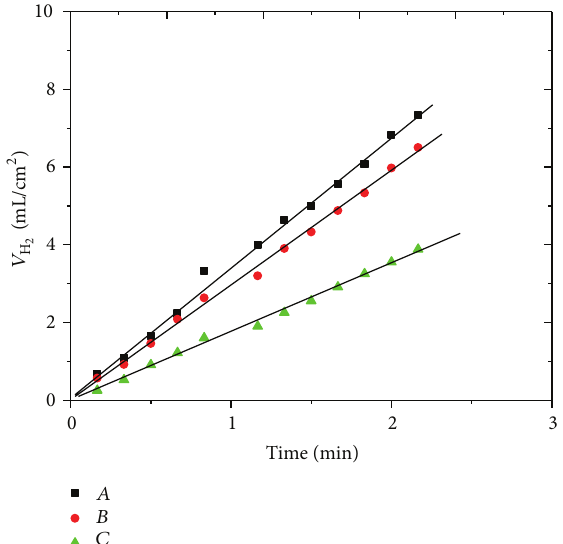
Figure 3: Plots of evolved 𝑉 versus time for corrosion of Al in H 2 alkaline media in absence of inhibitors at 30 ∘ C. [OH − ]: (𝐴) = 2.0 ; (𝐵) = 3.0 ; (𝐶) = 4.0 moldm −3 .